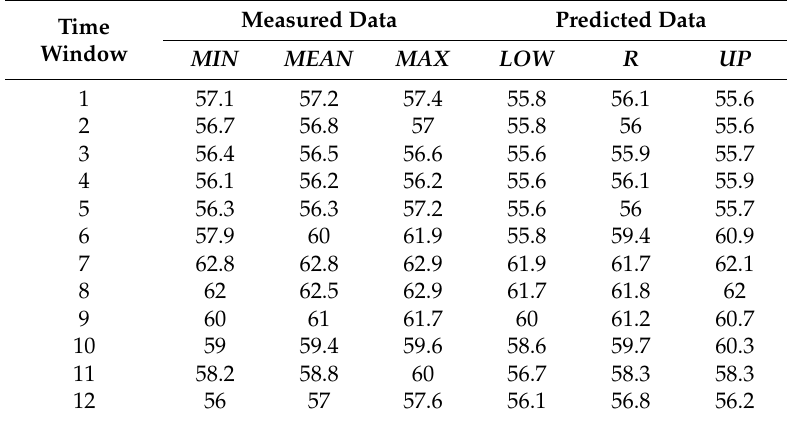
Table 4. Comparison of the measured data and the predicted data.